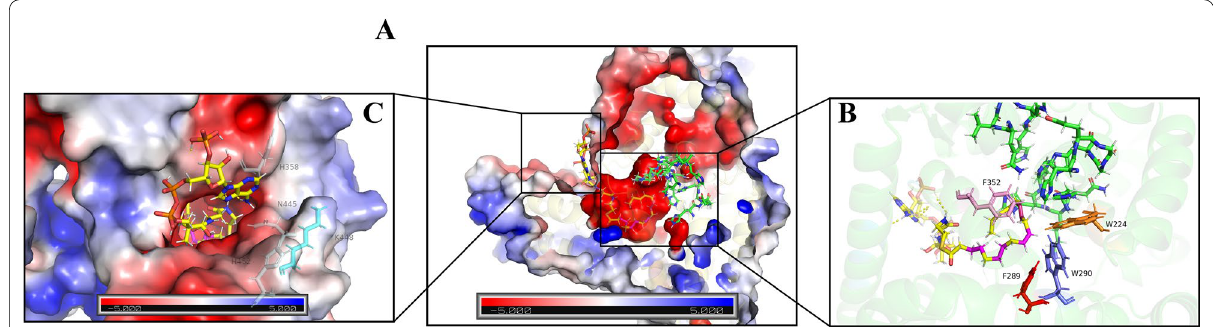
Fig. 2 Molecular docking simulation showing the potential interaction of Mp FADS6 with ALA-CoA. A Electrostatic surface of Mp FADS6_ALA-CoA complex B Cartoon of the Mp FADS6_ALA-CoA complex. C Electrostatic surface of the head group in the Mp FADS6_ALA-CoA complex. The atoms are highlighted in light red in ALA-CoA, indicating the sixth and seventh carbons from the methyl end. The atoms highlighted in magenta indicate the position of the fatty acid unsaturated bond